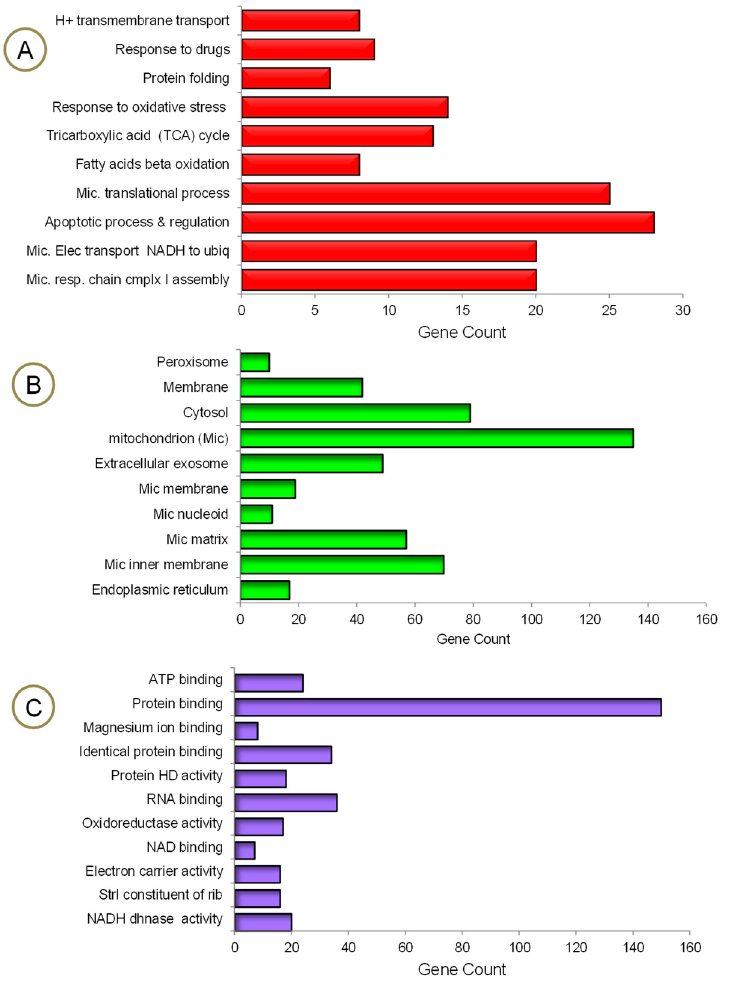
Figure 4. Gene ontology enrichment analysis of mrfDEGs. ( A ) Biological processes, ( B ) cellular com- partments, ( C ) molecular functions. HD: homodimerization, Strl: structural, dhnase: dehydrogenease, rib: ribosome.